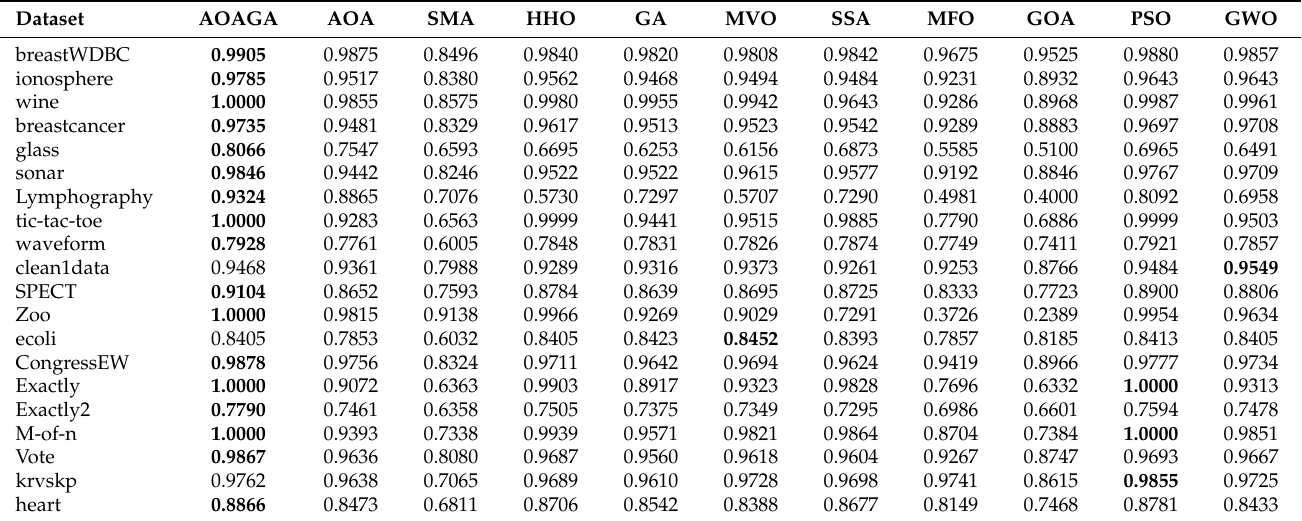
Table 6. Results of the accuracy measure for all